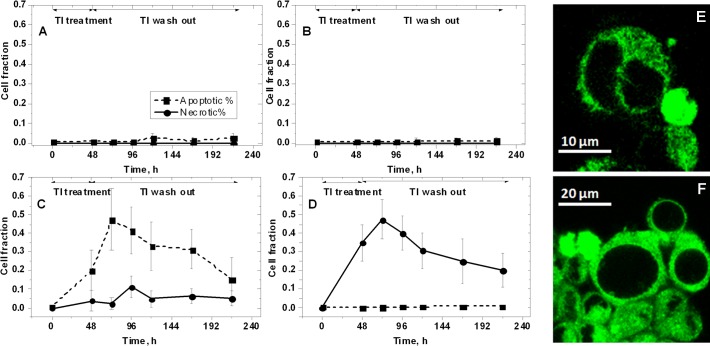
Apoptosis and necrosis incidence in cell cultures 48 h after the incubation and during the following 7 days of reperfusion: A) 0 Tl; B) 1 μg/L Tl; C) 10 μg/L Tl; D) 100 μg/L Tl. Representative images of apoptotic (E) and necrotic, swelled (F) neurons.